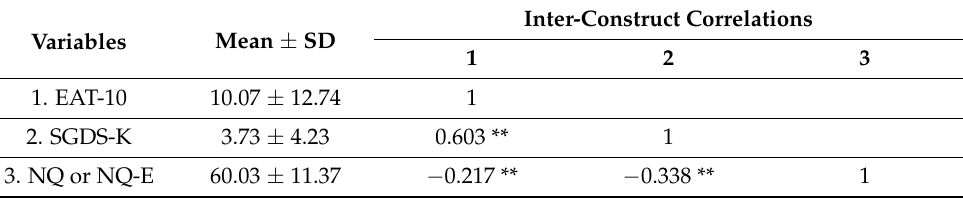
Table 6. Correlations between the 10-item Eating Assessment Tool, Nutrition Quotient/Nutrition Quotient for the Elderly, and the Short-Form Geriatric Depression Scale for Koreans.